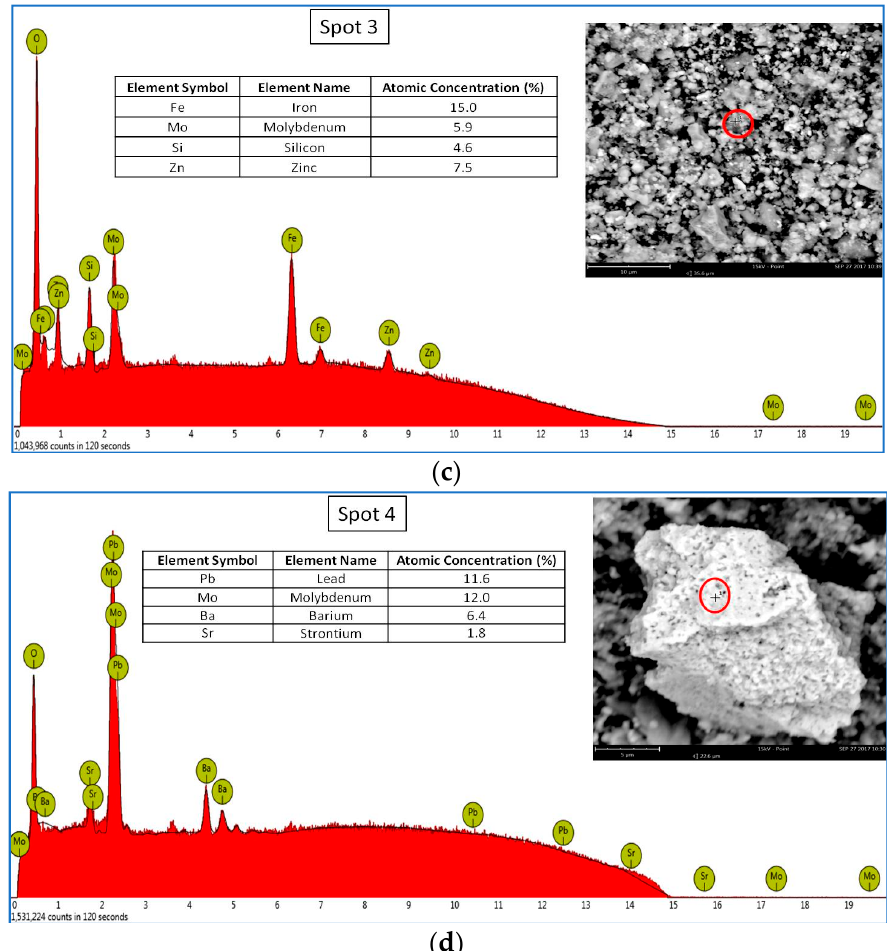
Figure 1. SEM images and EDS elementary analysis of zinc ferrite on different observation spots: ( a ) spot 1; ( b ) spot 2; ( c ) spot 3; ( d ) spot 4.